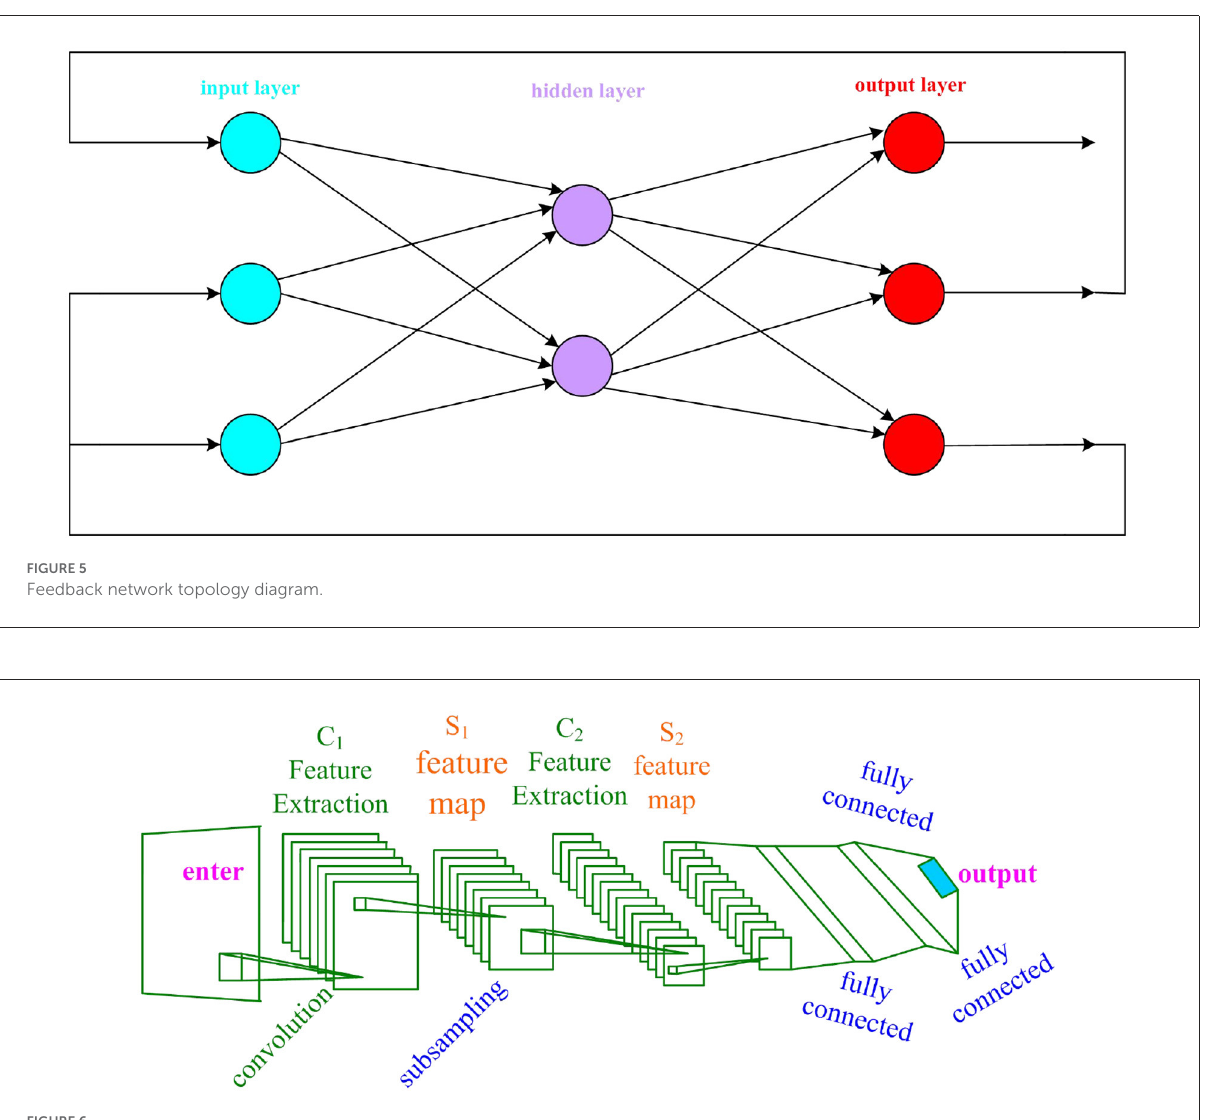
FIGURE6 Convolutional neural network topology diagram.